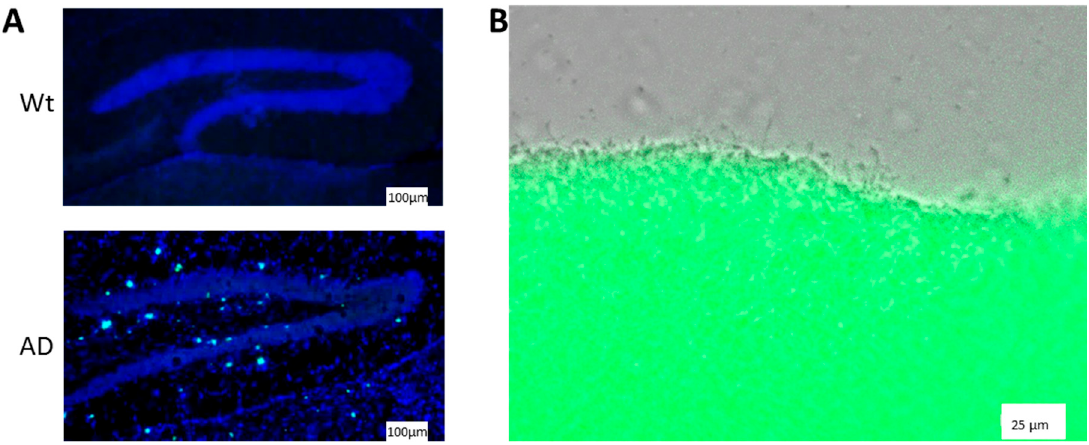
Figure 1. Amyloid deposits in the brain of an AD mouse model and in Escherichia coli biofilm layer. ( A ) Sagittal sections of murine brain were fixed with 4% PFA and amyloid plaques stained with ThT (turquois spots; merged with blue counterstain of cell nuclei by DAPI). The region of hippocampus of an AD model mouse (5 × FAD, [24]) is shown in comparison to a wild type mouse brain (Wt). ( B ) E. coli bacteria (DH5 α ) were grown for 48 h on YESCA agar and the biofilm stained with ThT (shown is a merge of bright field and green fluorescent channel).